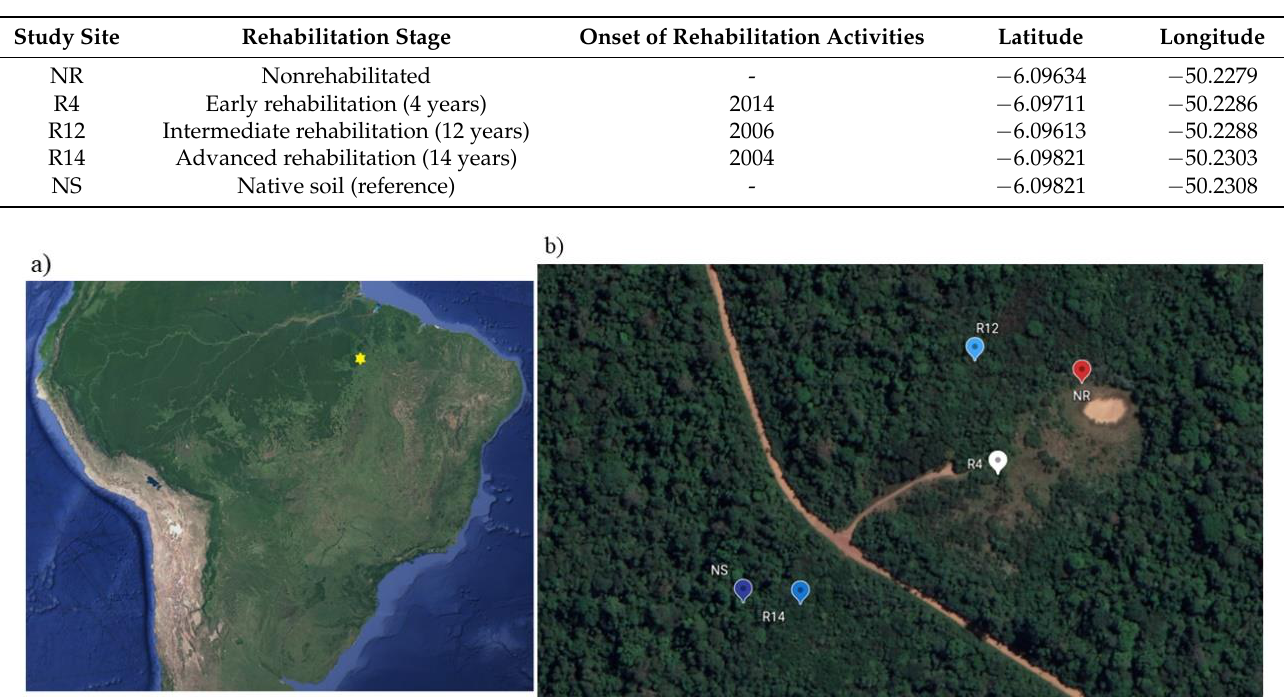
Table 2. Geographic location, rehabilitation stage, and timing of the initiation of rehabilitation activities of the study sites.